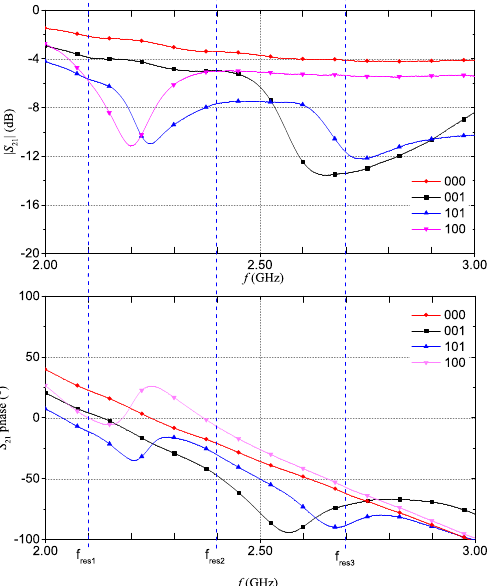
Figure 10. Measurement results for the multi-stopband structure: measurements of the magnitude ( top ) and phase ( bottom ) of the S 21 for ‘000’, ‘001’, ‘101’, and ‘100’